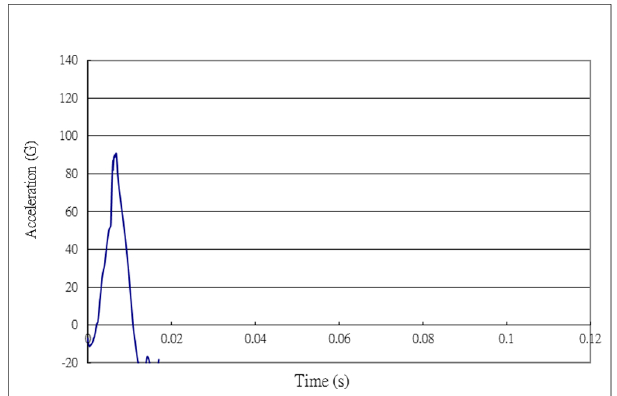
Figure 15. Four half-spheres served as the impact target.